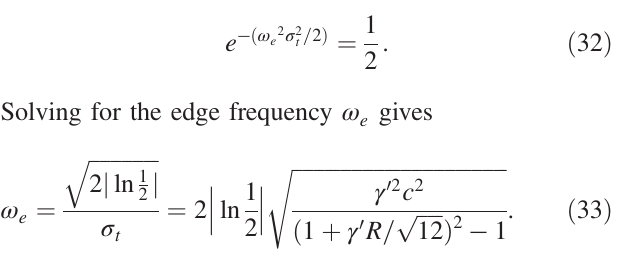
radii.FIG. 6. Comparison of the image field given by Eqs. (23) and (24) (solid red curve) with the heuristic Gaussian function in Eq. (25) (dashed blue curve). The disk radius is 1 mm, ¼ 20 MV = m, and the cathode dielectric constant is 100. E a The field is given per picocoulomb of negative disk charge. The inset shows the disk position from the cathode as a function of the